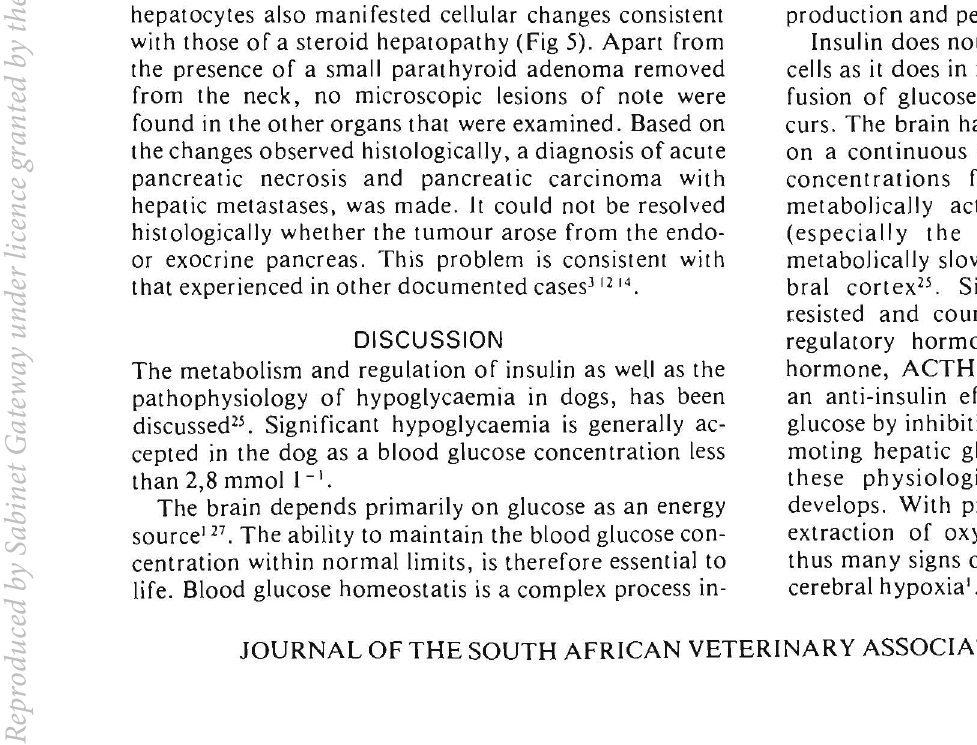
Fig. 3: Pancreas scintigraphy. Defects can be seen in the pancreas and liver the pancreas. A few small (2 mm diameter) pale foci were scattered throughout the right medial lobe of the liver while a single haematoma occurred in the spleen.